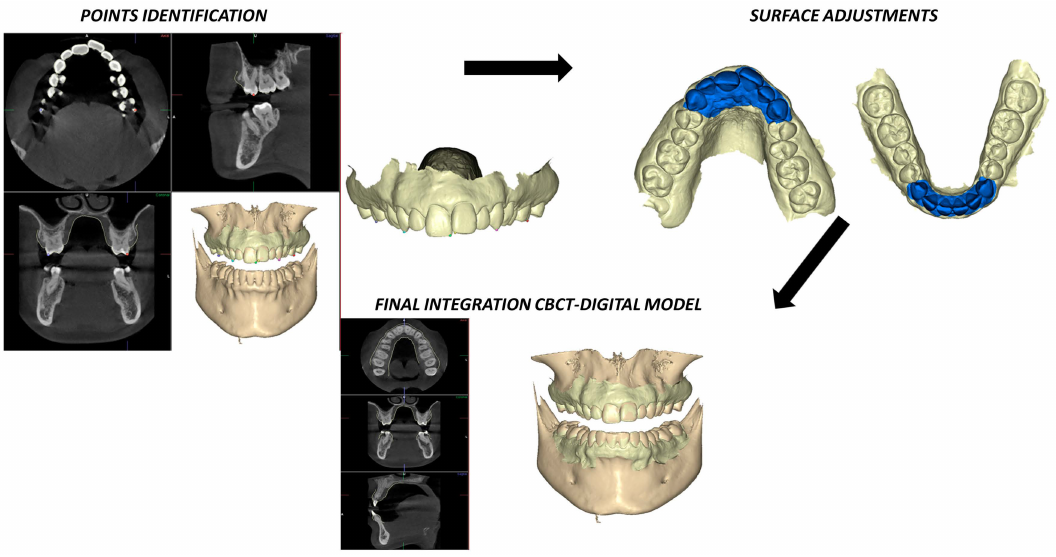
Figure 3. Cone-beam computed tomography overlay and digital model using dot